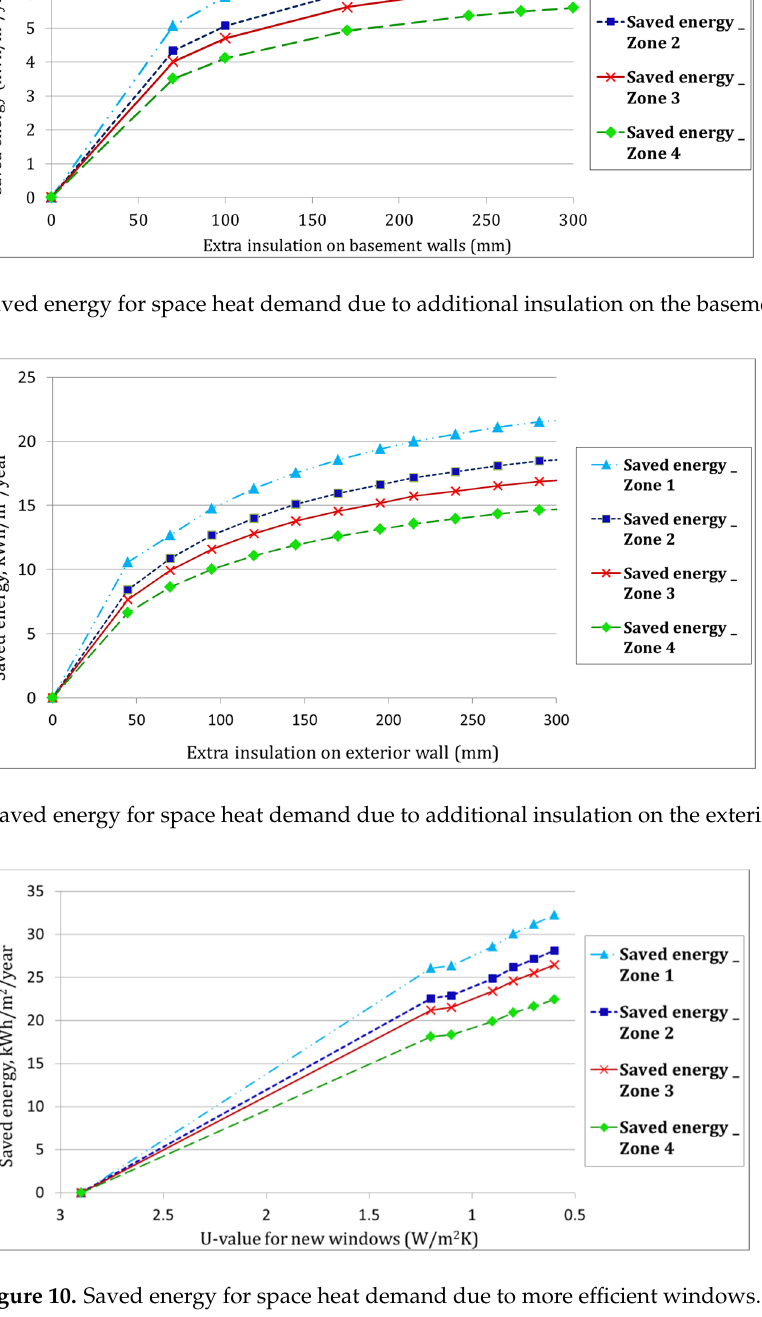
Figure 10. Saved energy for space heat demand due to more efficient windows.